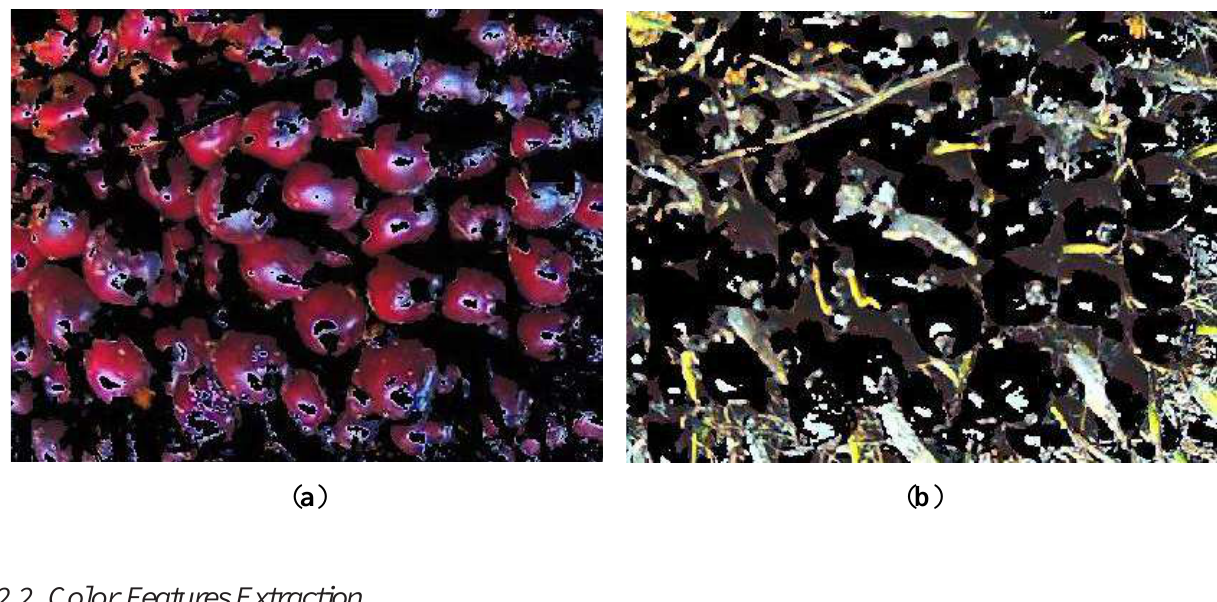
Figure 3. Segmented images of oil palm FFB’s ( a ) fruits and ( b )